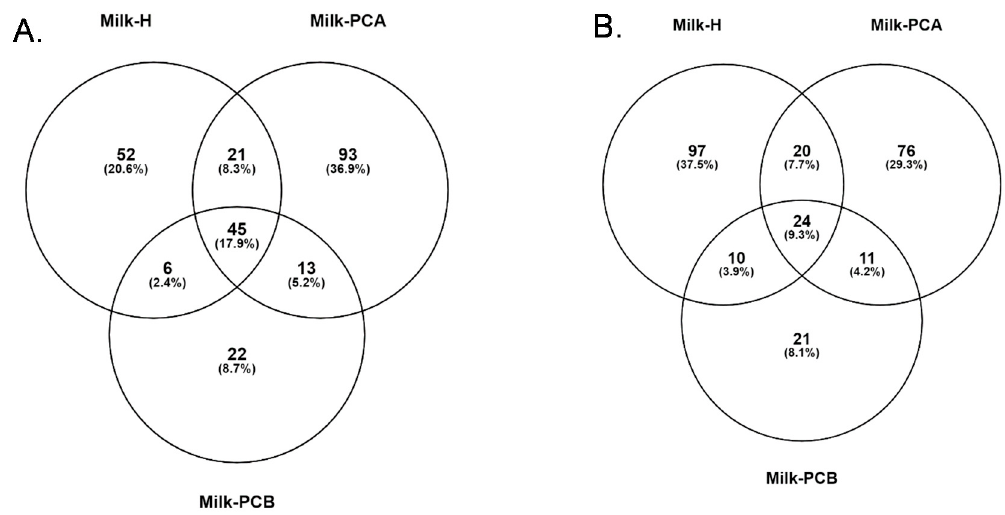
Figure 6. Common and di ff erent bacterial genera and species between the two “doing-the-month” and one “non-doing-the-month” milk groups. Venn diagrams showing the number of bacterial genera ( A ) or species ( B ) shared between or unique to the three milk groups, excluding bacterial genera or species present at an abundance of < 1%. The keys for milk-H, milk-PCA, and milk-PCB are described in Table 1. Briefly, milk-H: “non-doing-the-month” milk group; milk-PCA and milk-PCB: “doing-the-month” milk group.